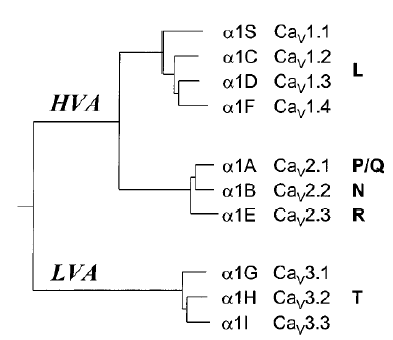
Figure 1. Evolutionary tree of voltage-gated Ca 2+ channels (modified according to